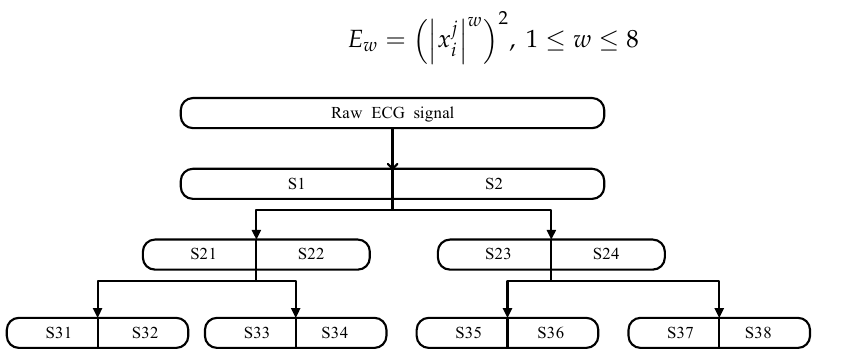
Figure 2. The flowchart of three layers’ wavelet decomposition.